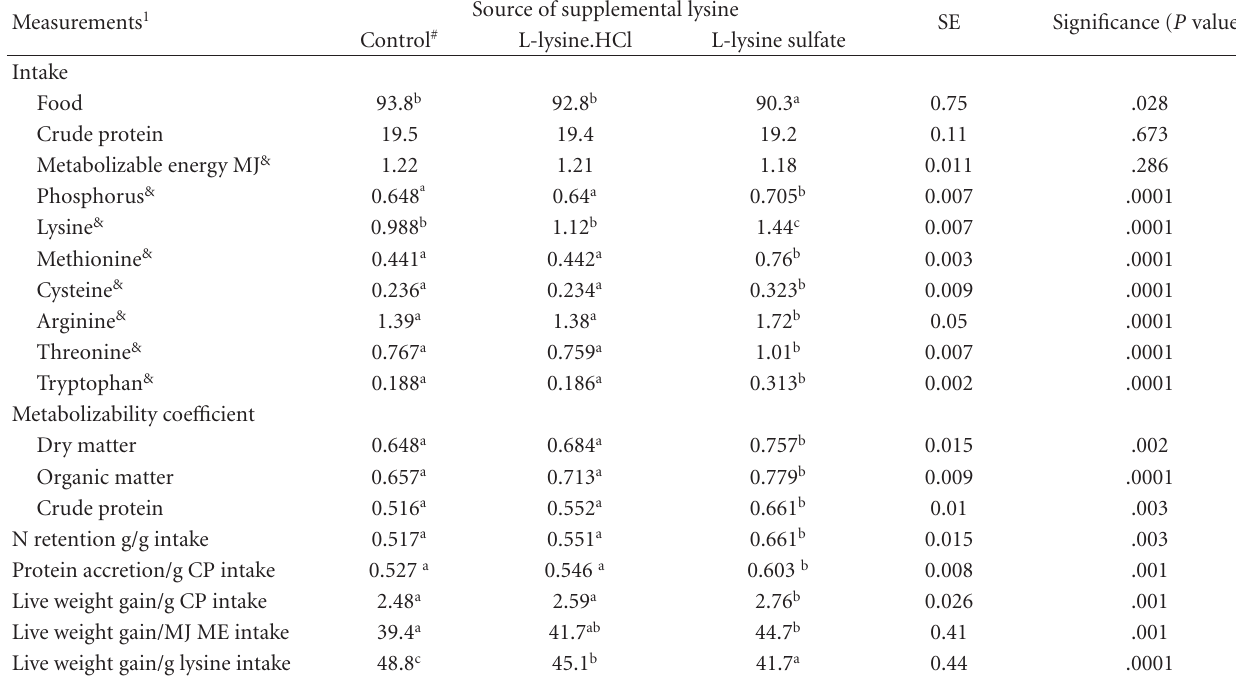
Table 5: Intake (g/day unless stated otherwise) and metabolizability coe ffi cients (g/g nutrient intake) of nutrients in broiler chickens fed diets supplemented with L-lysine.HCl and L-lysine sulfate.